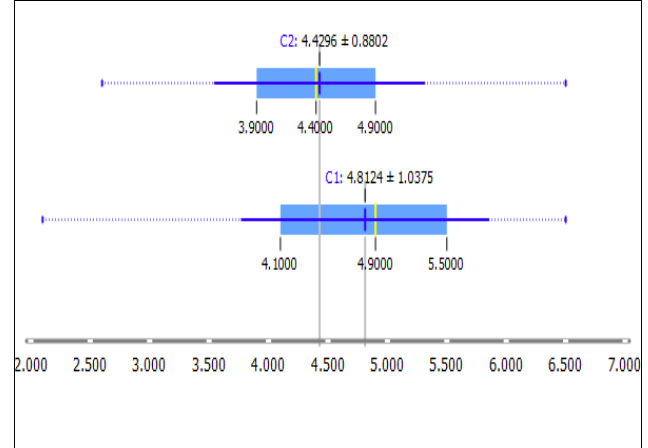
Figure 16. Data distribution of the Red Blood Cell RBC count in a box-plot showing the range of the data, its mean value after clustering the data using the K -means clustering technique. Here, 0.0 reresents the cluster for the non-hypertension class and 1.0 represents the hypertension class. It can be seen that the two sets of data are overlapping in nature.